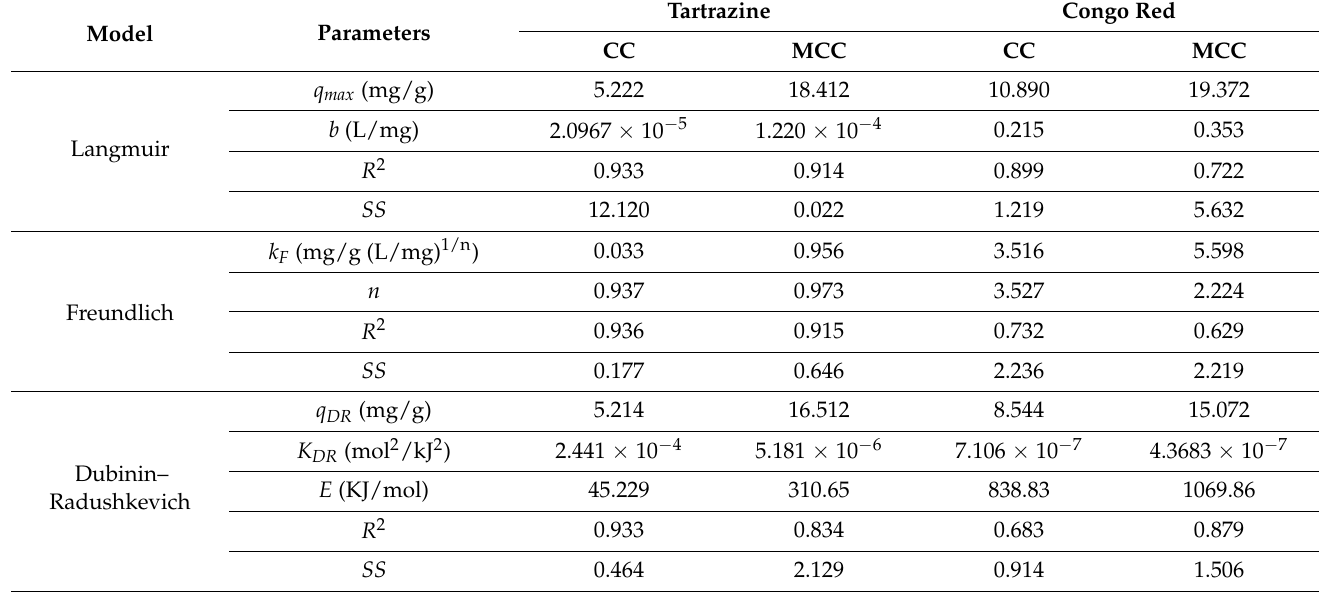
Table 4. Adsorption isotherm